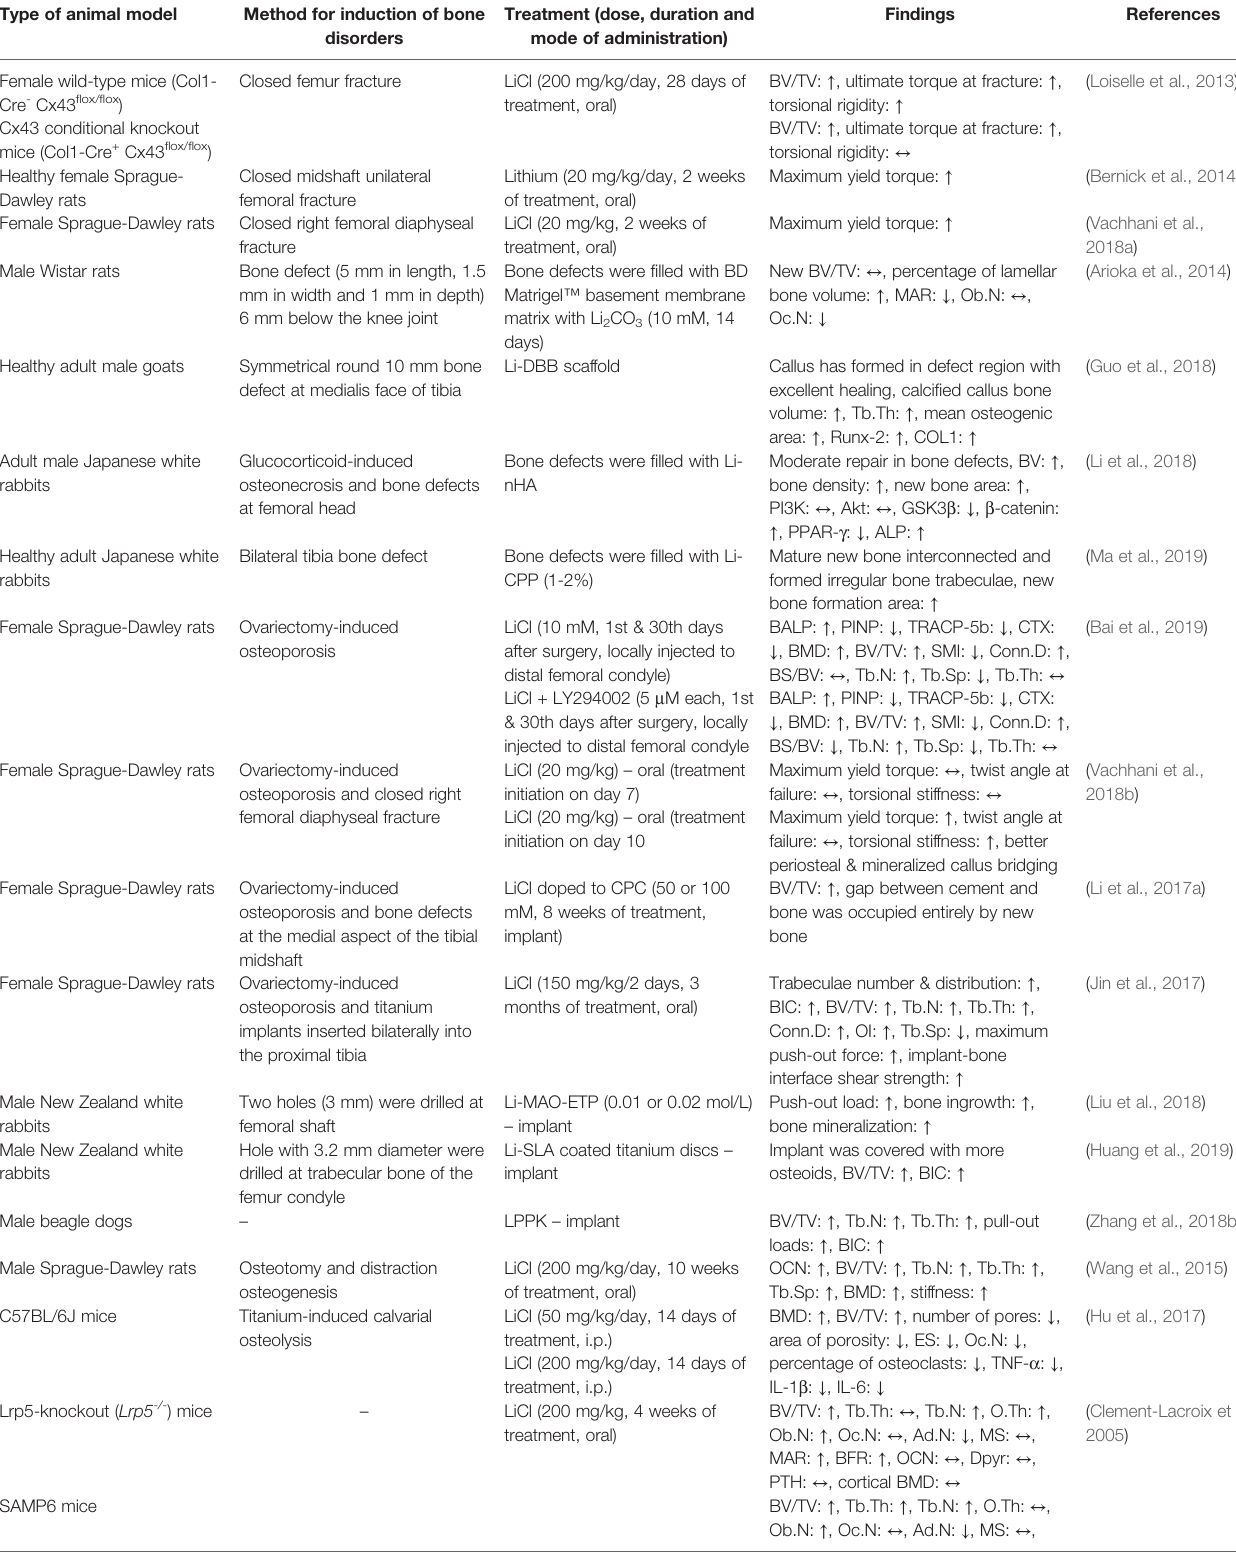
TABLE 1 | Effects of lithium on bone in vivo